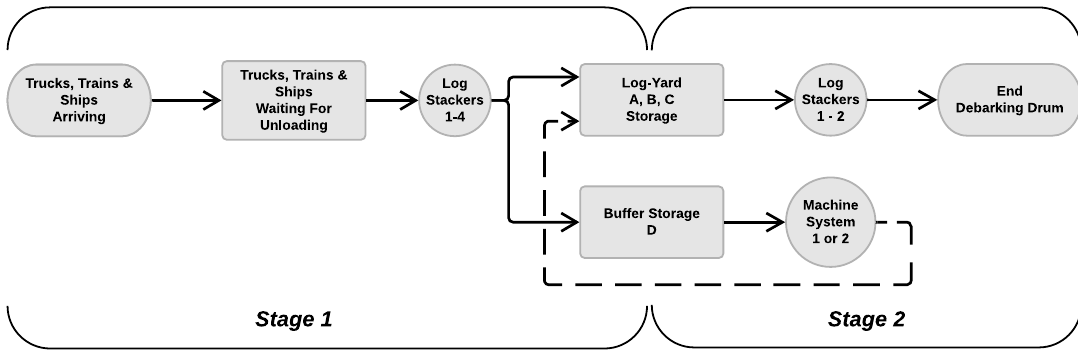
Figure 1. General layout of the logistics system at a pulp